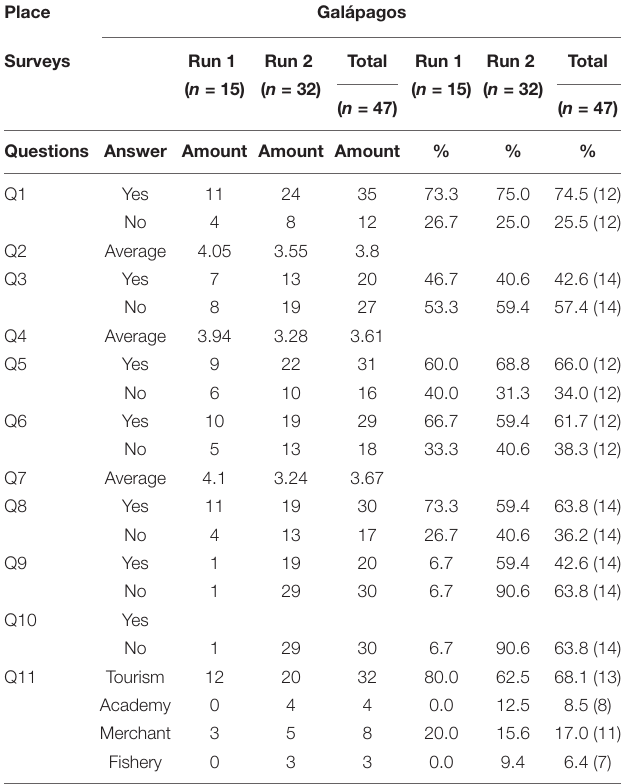
TABLE 2 | Results from